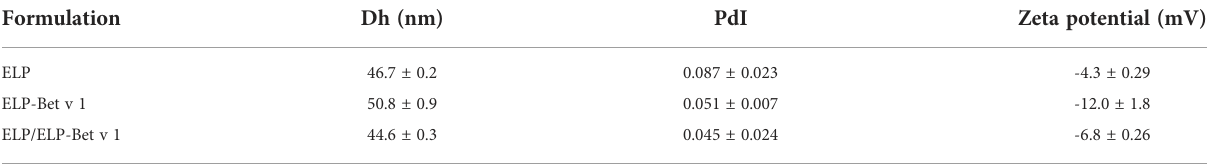
Polypeptide solutions of 10 µM in phosphate buffered sucrose (DLS) or 2.5 µM in 10 mM PB (zeta potential) were measured at 37°C. The corresponding size distributions are shown in Figure